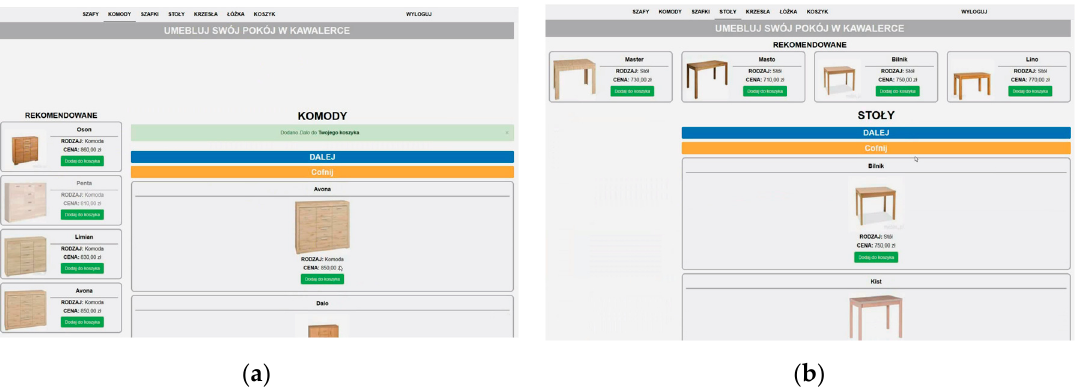
Figure 2. Recommendation layouts of the recommending interface: ( a ) vertical; ( b ) horizontal.